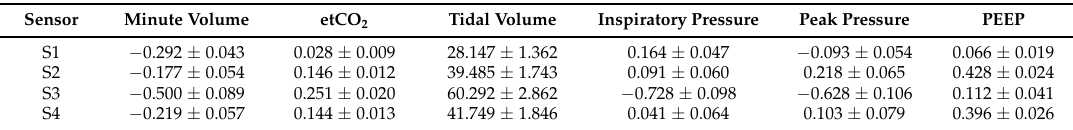
Table 3. Fixed effects regression coefficients of ventilation parameters vs. sensors. Values indicate mean fixed effect regression coefficients ± their 95% confidence intervals.